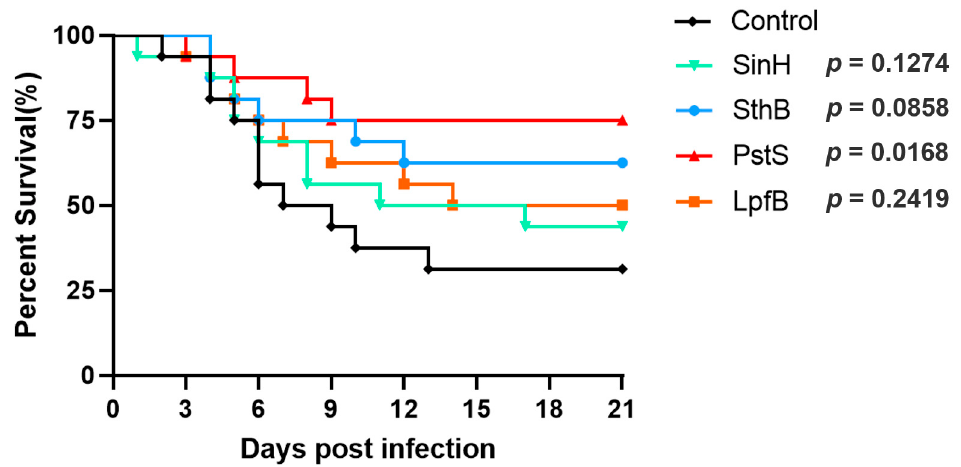
Figure 6. Survival percentage of PBS, SinH, SthB, PstS, and LpfB immunizing chicks infected with S. Pullorum R51. Survival of chicks was monitored for 21 days.